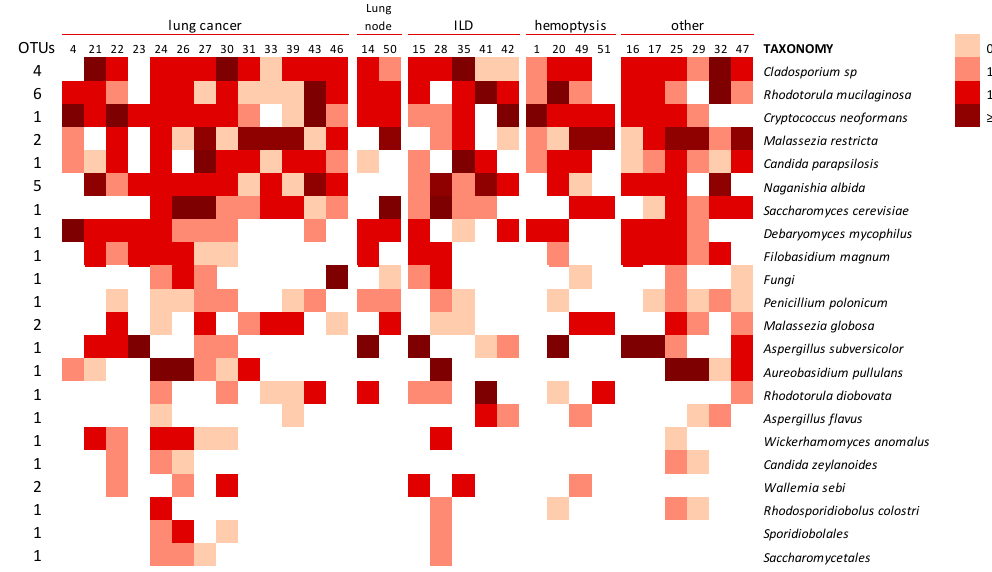
Figure 6. Distribution of fungal species detected in BAL samples clustered by the underlying disease or symptoms (others corresponded to: Thymoma, TBC sequels, Atelectasis, lung infiltrate, tracheal stenosis, and COPD, respectively). The intensity of the color corresponds with the number of sequences that match with the putative species in the UNITE database at 97% similarity (logarithmic scale). The column at the left identifies the number of OTUs that showed a hit with the same species shown in the left column. Species present in less than 10% of the samples and with less than 100 sequences are not shown.